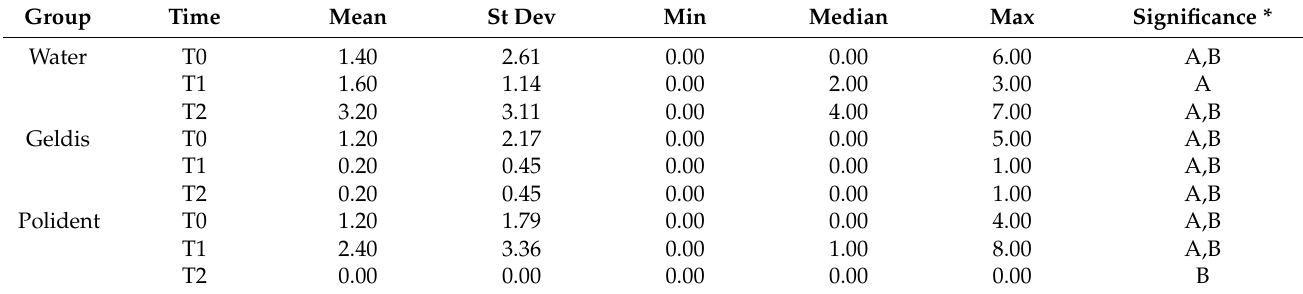
Table 4. Descriptive statistics of Bleeding on Probing measurements.